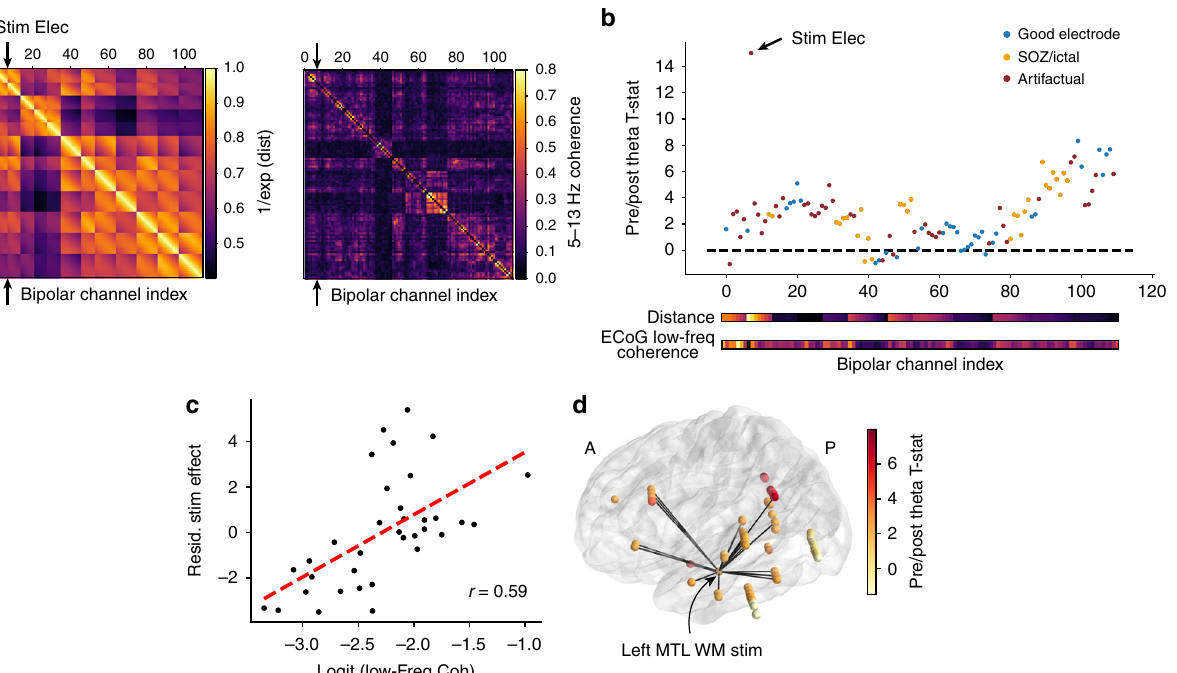
Fig. 2 Method for determining network-mediated activation (NMA θ ). a For each subject, Euclidean distances (left matrix) and functional connectivity (right matrix) are measured for all possible electrode pairs. Distances are linearized as e − (distance) , with 1.0 representing no separation between two electrodes. Functional connectivity is the averaged 5 – 13 Hz multitaper coherence in 1-s windows extracted from a baseline period. b Pre- and post-stimulation theta power (Fig. 1e) is compared with a paired t -test to generate a t -statistic for each electrode. Electrodes are excluded from analysis if they exhibited signi fi cant post-stimulation artifact (red, see Methods for details) or were placed in the seizure onset zone or exhibit high inter-ictal spiking (orange). c Multiple linear regression is used to correlate the logit-transformed functional connectivity (between a recording electrode and the stimulation electrode) with the power t -statistic, independent of distance. To demonstrate this, the distance-residualized t -statistic ( “ stim effect ” ) is plotted against functional connectivity in the example subject. The z -scored version of this correlation is referred to as the “ network-mediated activation ( θ ), ” or NMA θ . d Rendering of the power t -statistic as color on each electrode in the example subject, plotted with the top 10% of functional connections to the stim electrode (black